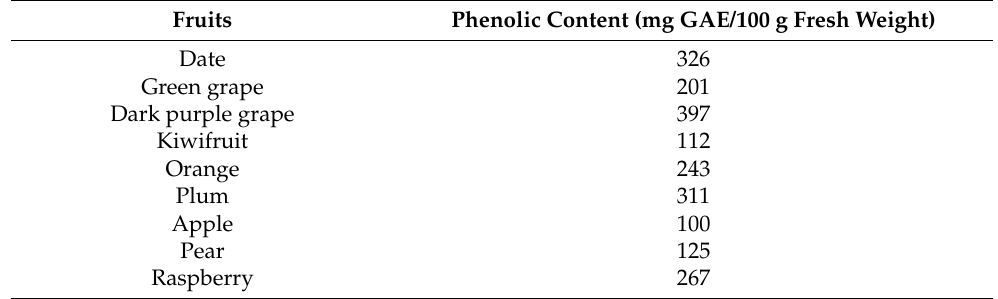
Table 2. Total phenolic contents of various fruits estimated by Folin-Ciocalteu method. Adapted from [20,33,53,64–67].